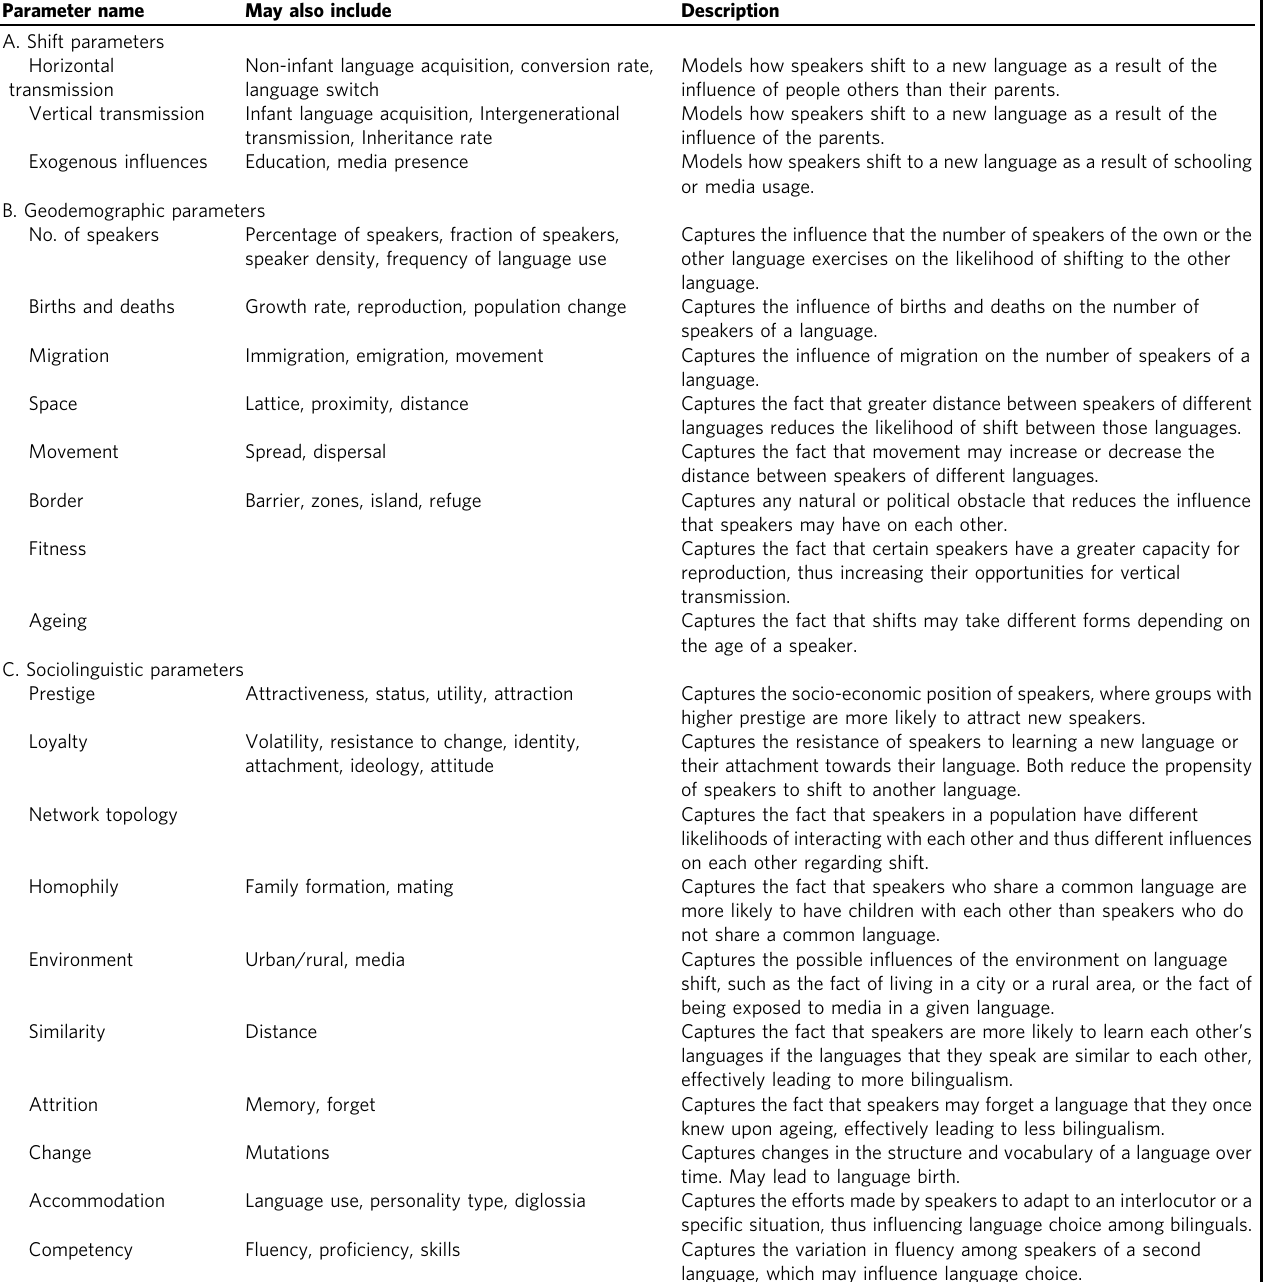
Table 1 List of parameters identi fi ed in the literature review and short